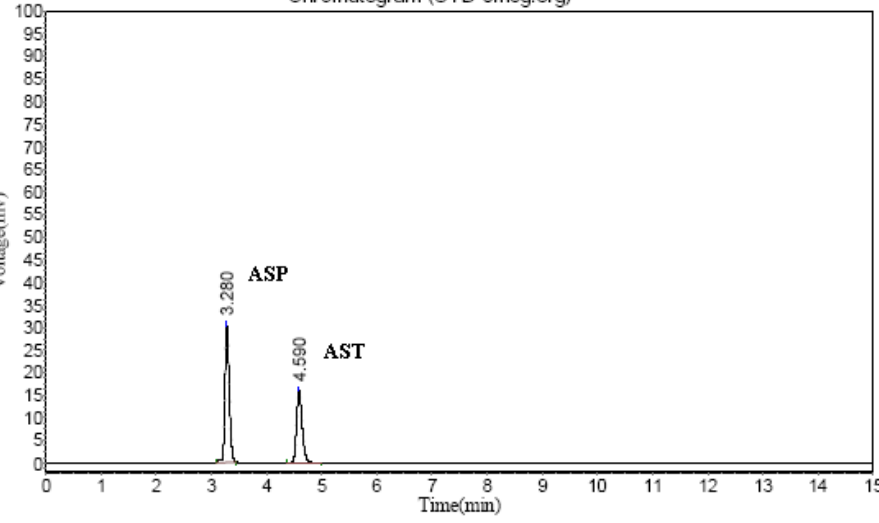
Figure 1. A Representative Chromatogram of Atorvastatin Calcium (AST) and Aspirin (ASP) at 245 nm.